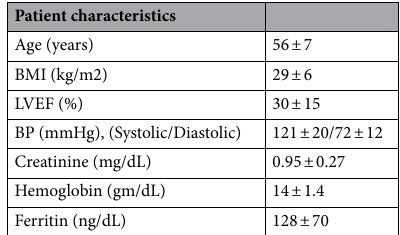
Table 2. Patient characteristics. Characteristics of the HF patient cohort are shown in the table in the form of mean ± standard